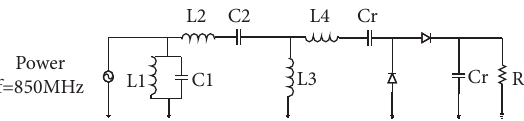
Figure 36: Te rectifer with one branch only.